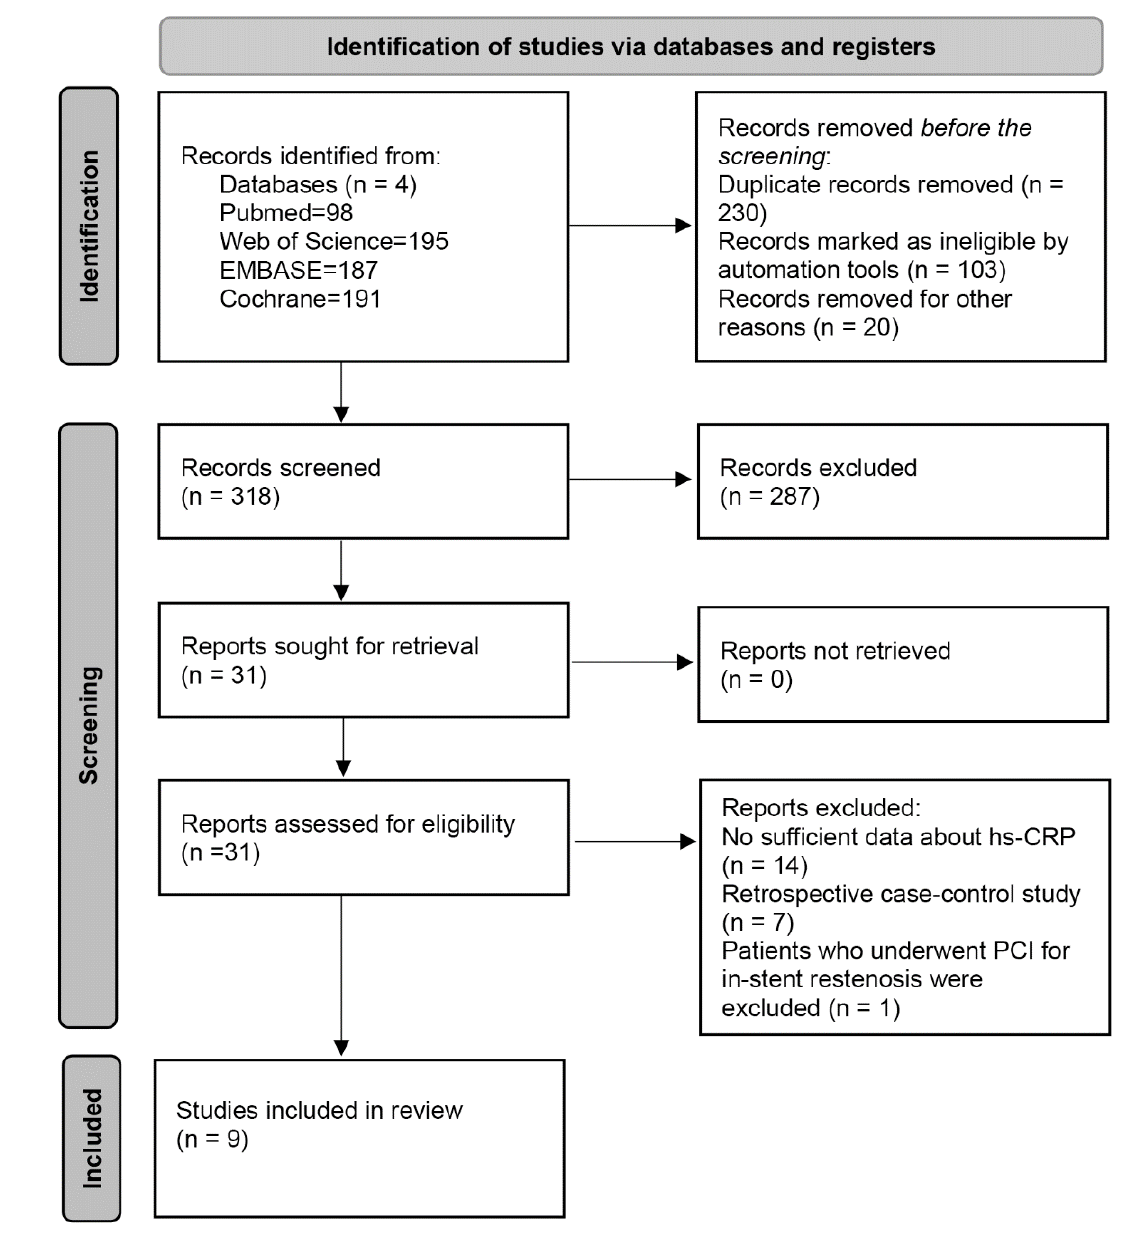
Figure 1. Flow diagram of eligible studies included in the meta-analysis.